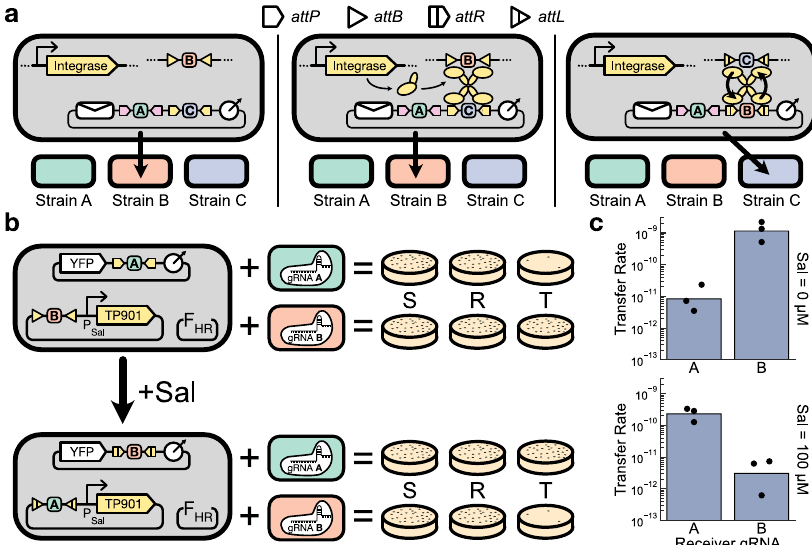
Fig.5|Integrase-mediatedaddressediting.a Schematicoftheprocess.Intheleft panel, expression of the integrase has not been induced, and no editing has occurred. The message is addressed to Strain B. Orthogonal integrase attachment sites fl ank each binding site on the address region. In the middle panel, the inte- grase associated with the C site on the address region has been induced. The corresponding attachmentsitesforthis integrase arealso encoded separatelyona sequence distinct from the message plasmid. In the right panel, the cassette exchange process has been completed, and the C site on the address region has been swapped with a B site, updating the message ’ s recipient list to Strain C. The processisunidirectionalasitconvertstheattBandattPsitesintoattLandattRsites